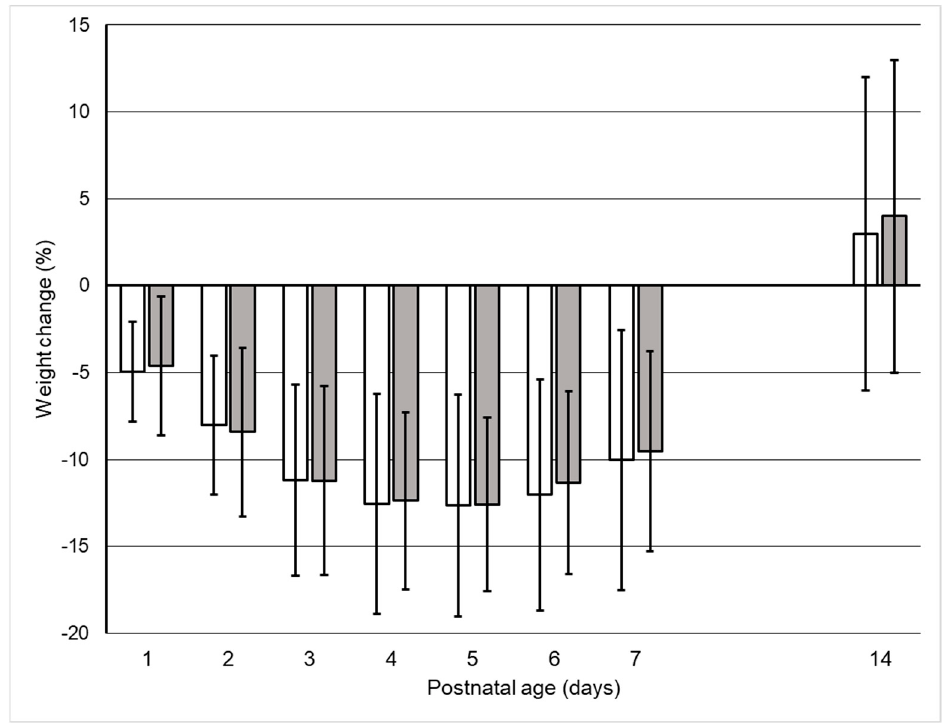
Figure 3. Relative changes in body weight. RESTRICTED group, open bars; LIBERAL group, filled bars; Mean ± SD. Table 3. Plasma sodium during 1st week and related morbidities.